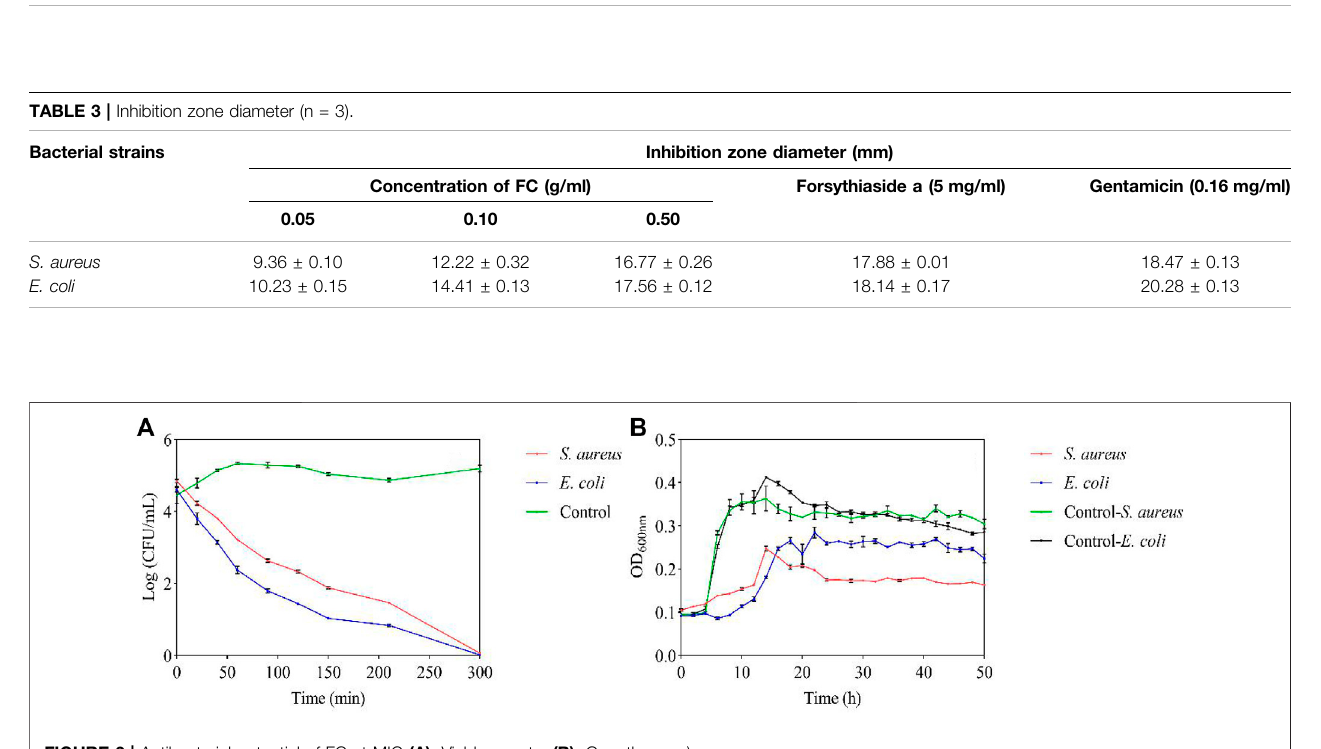
FIGURE 3 | Antibacterial potential of FC at MIC (A) : Viable counts. (B) : Growth curve).